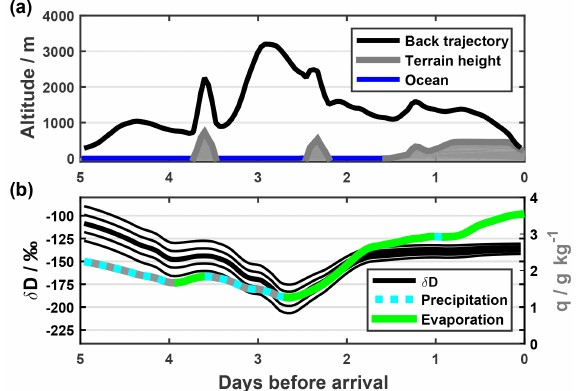
Figure 3. Illustration of the isotope modeling for one exem- plary back trajectory (arrival in Karlsruhe on 18 March 2012, 00:00UTC). (a) Altitude of the back trajectory (black) and terrain height (gray/blue). The isotope model was initialized at 80 ◦ N in the marine boundary layer (MBL). In a low-pressure system near Ice- land the tracked air parcel ascended to an altitude of 3200m. During the last 3 days of transport to Karlsruhe the air parcel was sinking to the sampling altitude. (b) After initialization in the MBL, spe- cific humidity q (light blue and green colored line) and δ D values (thick black line) of the tracked air parcel were slightly decreasing due to the formation of precipitation (dashed light blue lines) within the first day. More pronounced formation of precipitation, in conse- quence of lofting in a low-pressure system near Iceland, resulted in a second decrease of q and the modeled δ D value dropped accord- ingly. Due to moisture uptake (green lines) related to a descent of the air parcel in the subsequent days, q and the δ D value increased until the air parcel reached Karlsruhe. Thin black curves illustrate the modeled δ D for different initializations of δ D (Sect. 2.3.3). The dependence on the initialization decreases with the amount of mois- ture uptake along the trajectories and is only low in Karlsruhe.